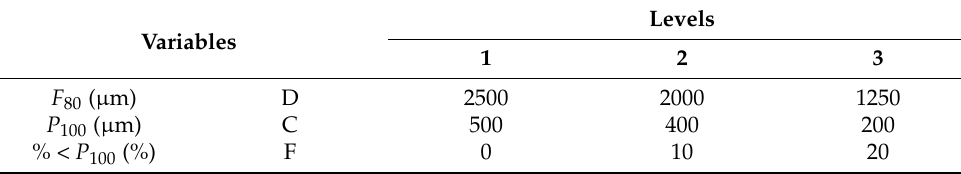
Table 2. Three levels multivariate experimental design.